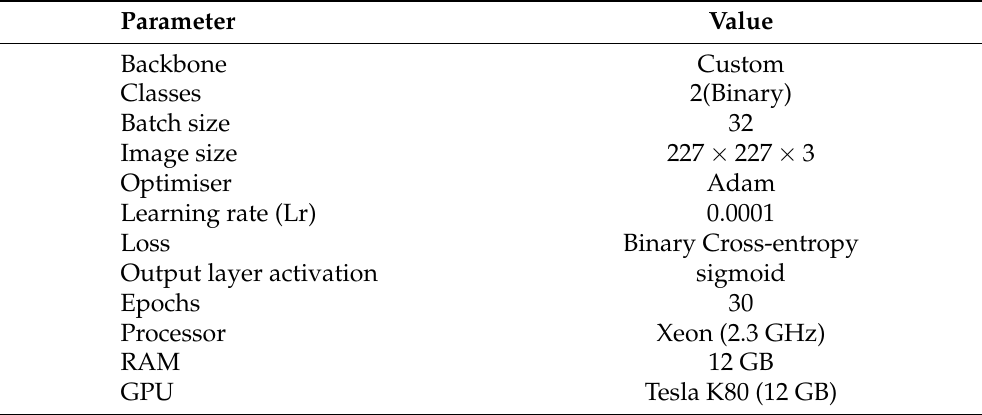
Table 6. Training hyperparameter and